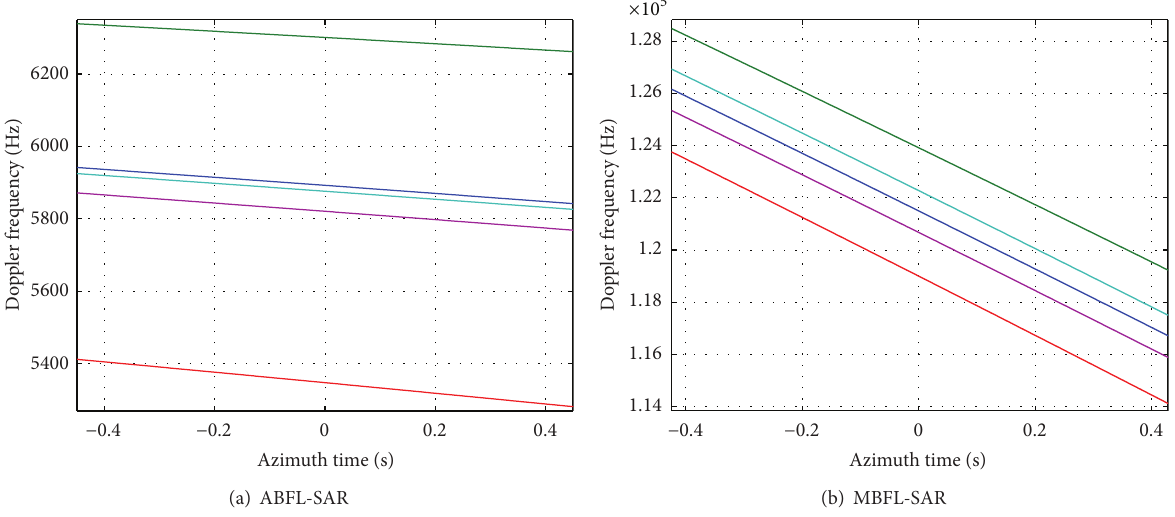
Figure 6: Doppler frequency comparison between ABFL-SAR and MBFL-SAR.